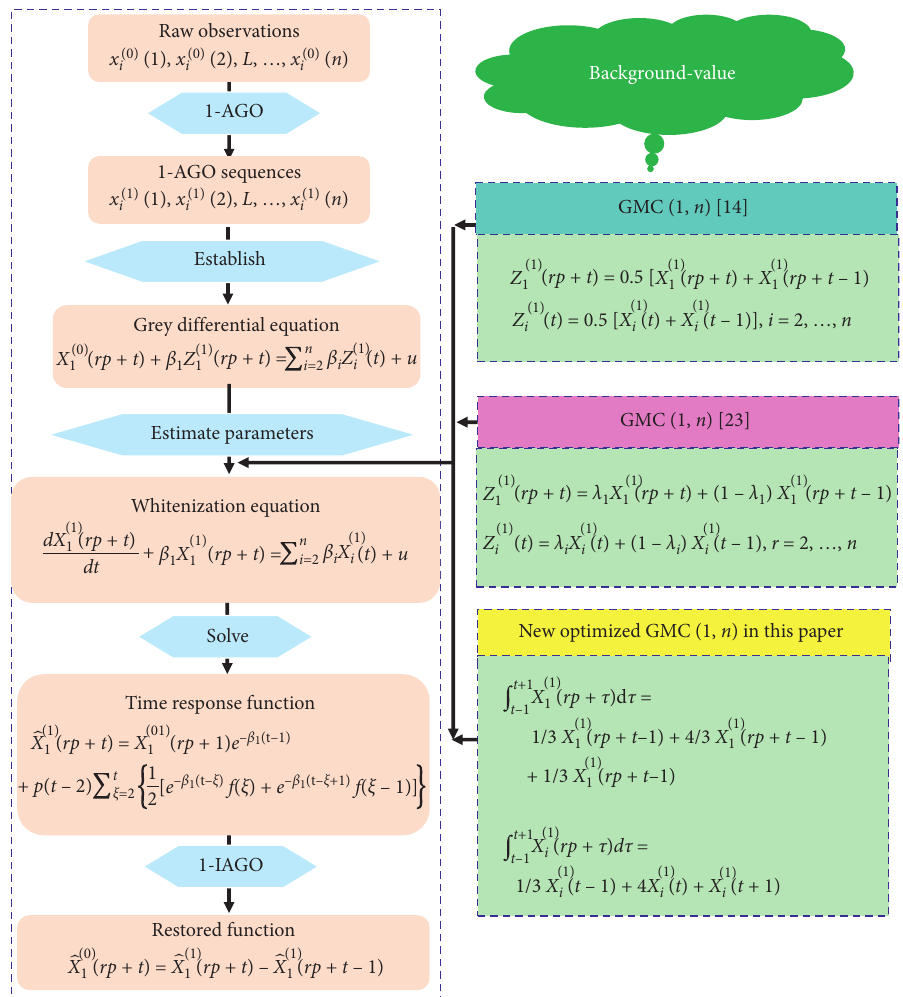
Figure 1: Flowchart of the GMC (1, n ) model with different approaches to estimating background